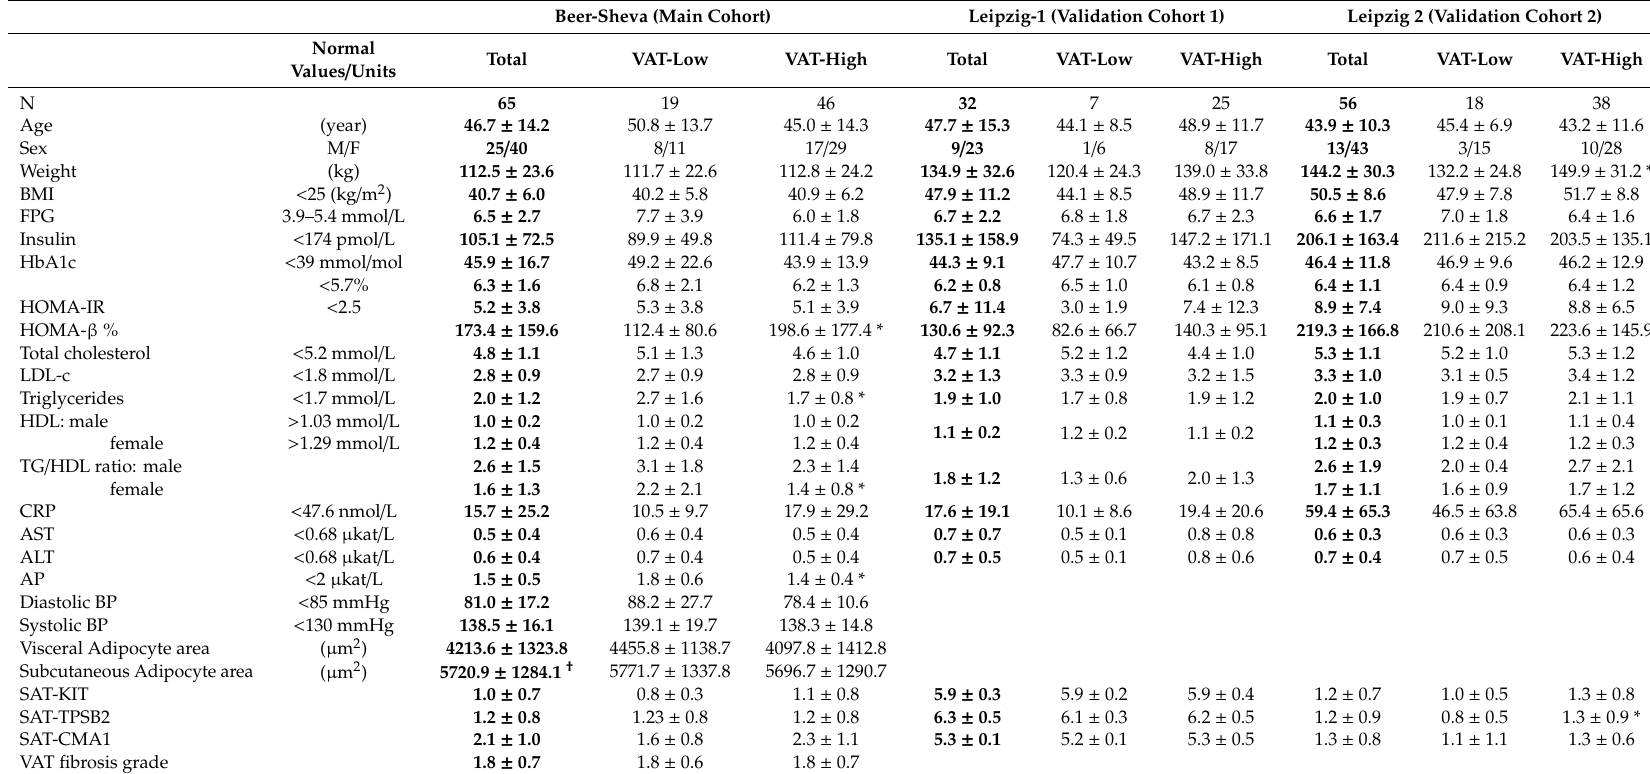
Table 1. Baseline characteristics of obese